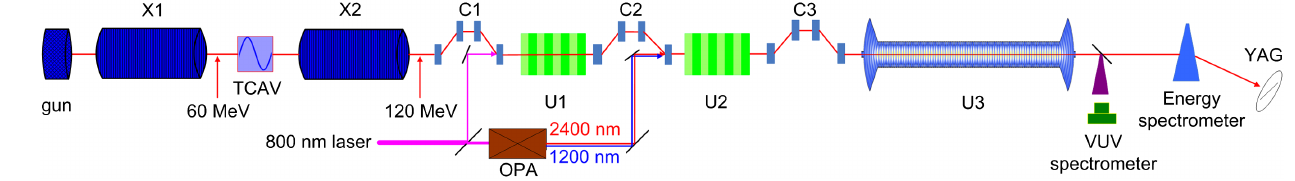
FIG. 3. Schematic of the EEHG experiment at SLAC. The beam is modulated by two lasers at 800 and 2400 nm, and coherent VUV radiation at 160 nm as the 15th harmonic of the second laser is produced in a microwave undulator